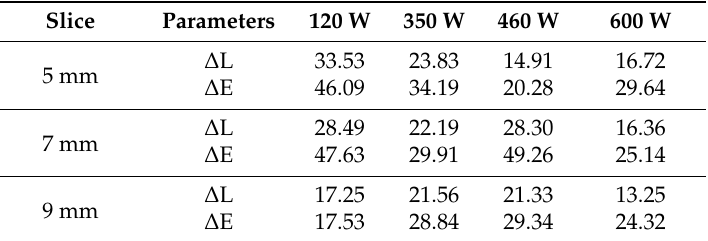
Table 3. Color parameter results.